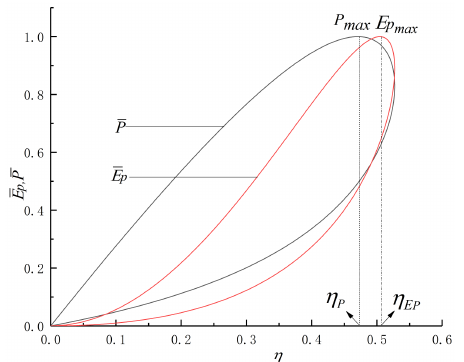
Figure 6. The relationships of P − η and E P − η